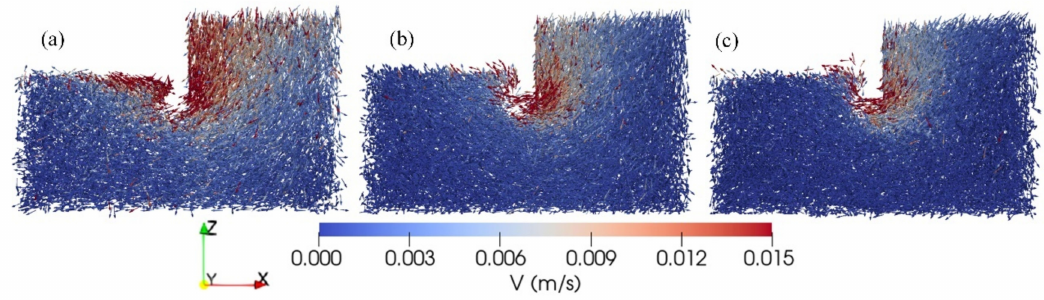
Figure 4. Evolution of particle velocity of specimen FC40 at t = ( a ) 0.01 s; ( b ) 0.1 s; and ( c ) 0.2